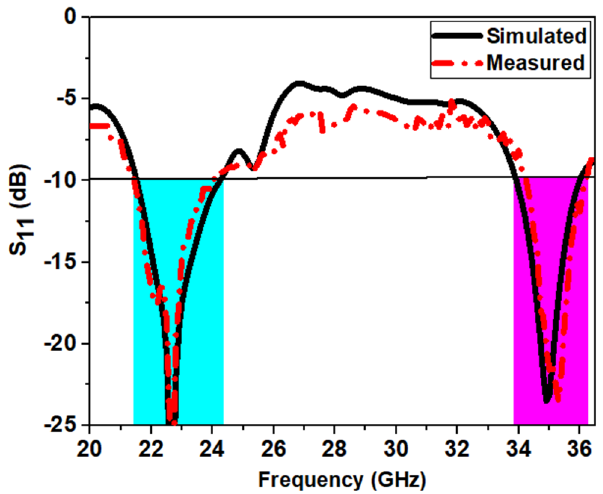
Figure 13. Reflection coefficient vs. frequency of the proposed antenna.